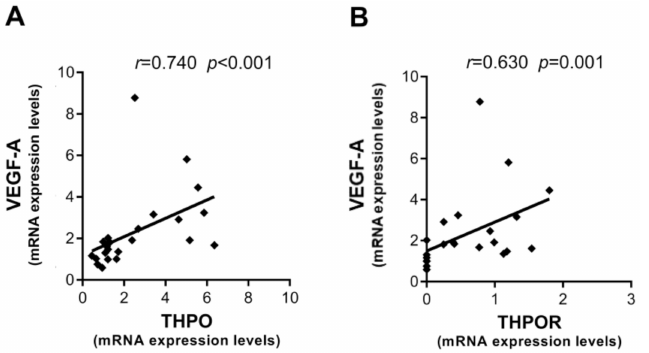
Figure 6. Interrelationships between mRNA expression levels of THPO, VEGF-A, and THPOR in LC. Correlations between mRNA expression levels of THPO and VEGF-A ( A ) and THPOR and VEGF-A ( B ). Analyses by Spearman correlation test; correlation coefficient r and p values are also shown.